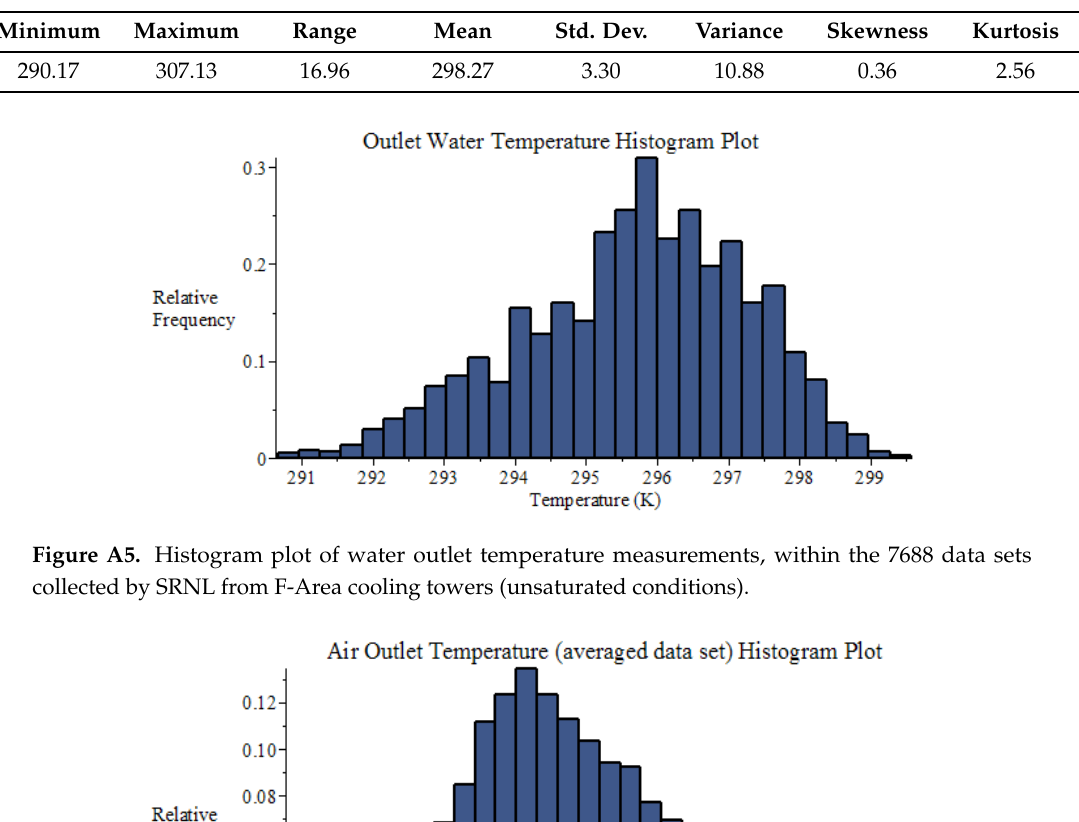
Table A5. Statistics of the averaged air outlet temperature distribution [K].